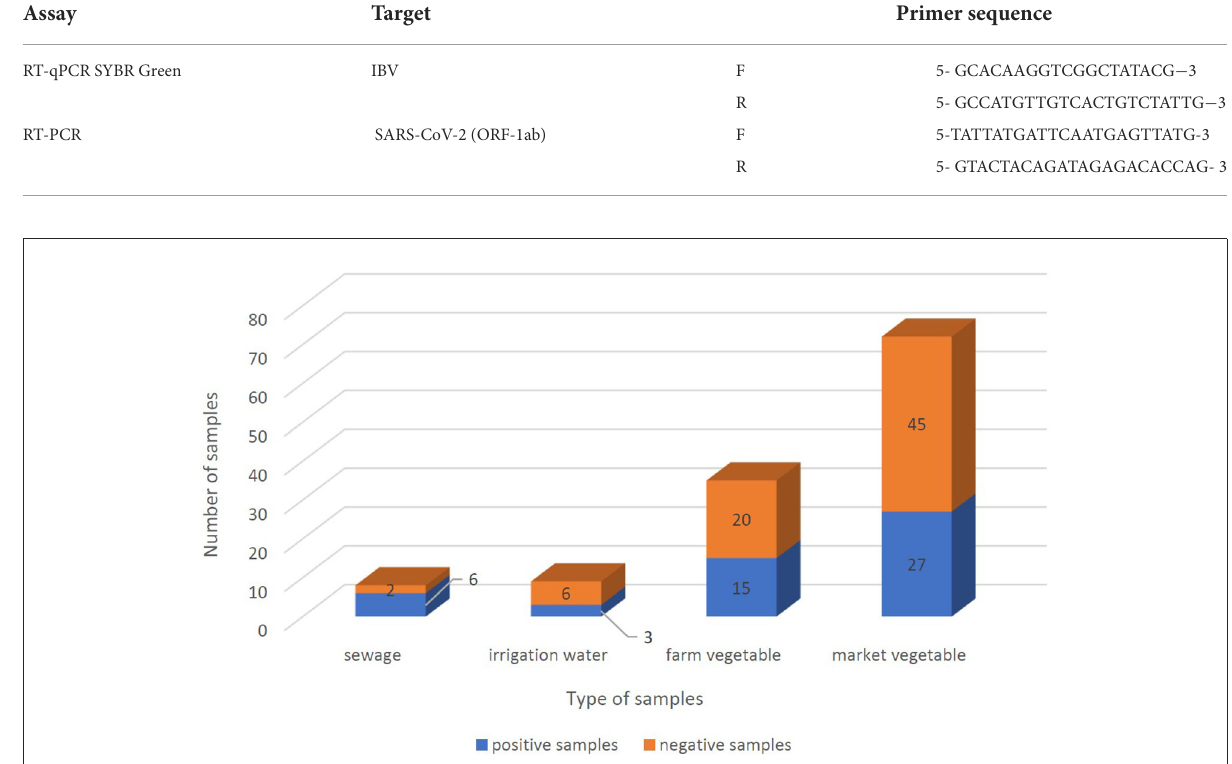
FIGURE3 Positivity of SARS-CoV-2 RNA frequency in sewage, irrigation water, farm vegetables, and market vegetables samples. Positive samples and negative samples are shown in blue and orange, respectively. And the whole columns show the total number of samples.